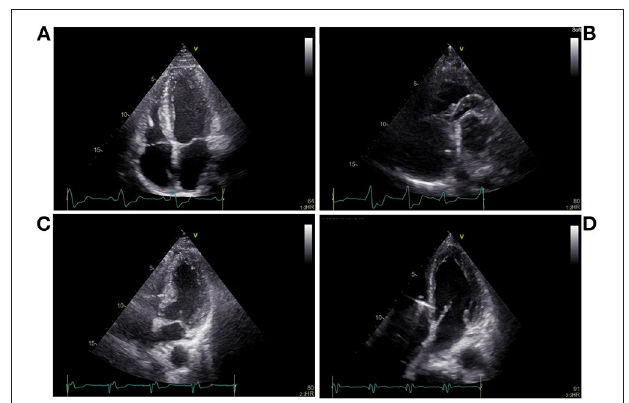
FIGURE 1 | Echocardiography during pacing at different sites. (A) Right ventricular apical pacing, (B) Right ventricular outflow tract pacing, (C) His bundle pacing, (D) Left bundle branch